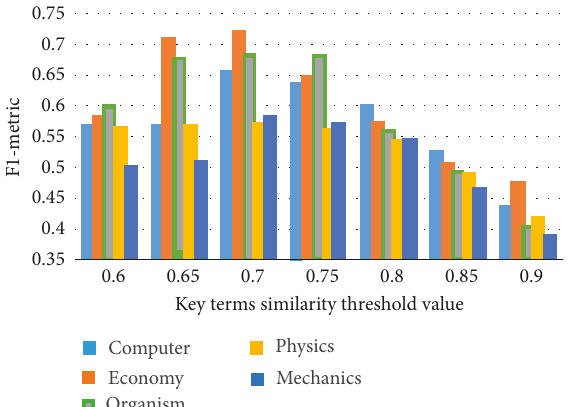
Figure 10: F1-metric comparison of various key similarity threshold